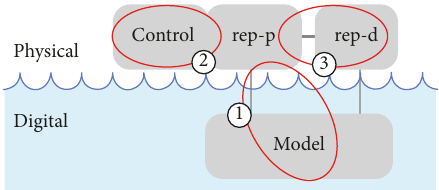
Figure 2: Interaction model of TUI by Ullmer and Ishii